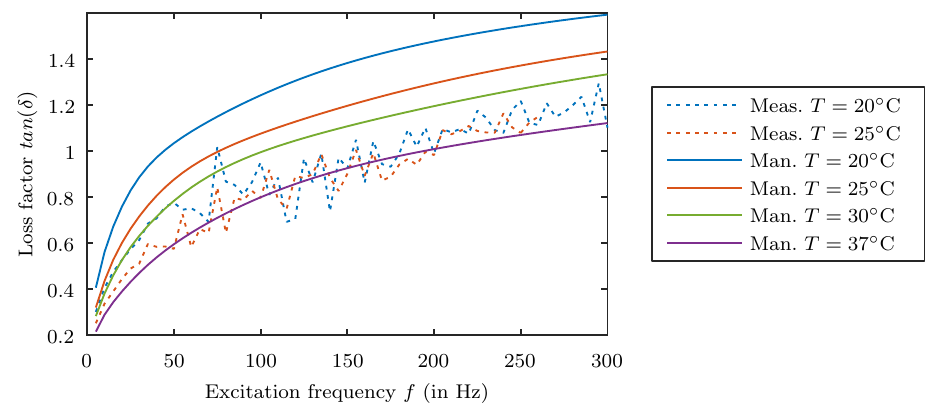
Figure 14. Comparison of measured loss factor with the manufacturer